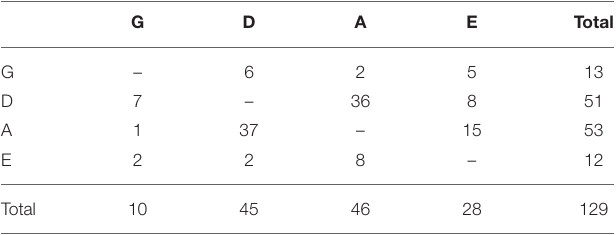
Rows: correct strings; columns: played strings.